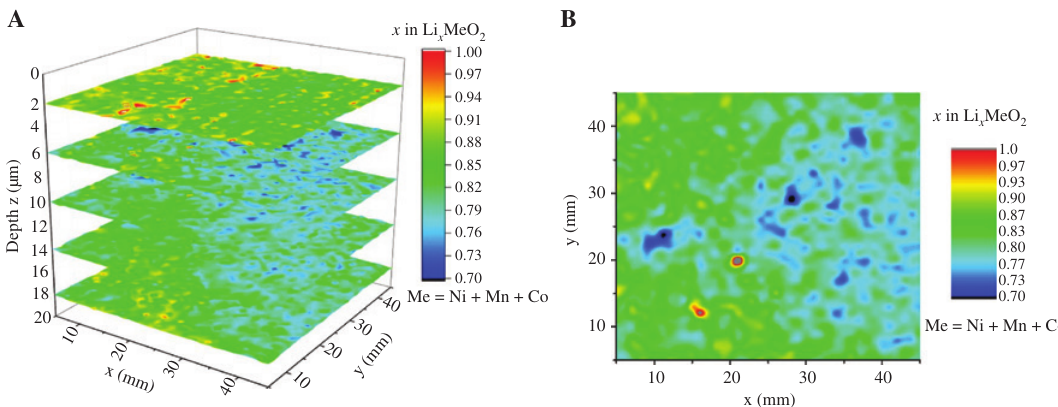
Figure 27: LIBS lithium elemental mapping of an electrochemically cycled and degraded NMC pouch cell electrode (5 × 5 cm 2 ). The amount of x of lithium in Li of lithium concentration (second layer). The depth per pulse is 4 μ